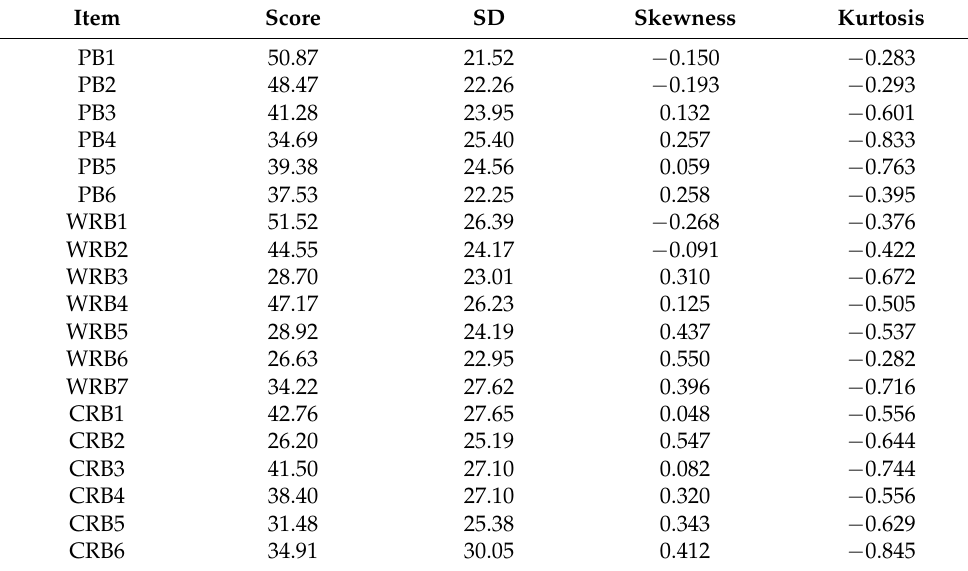
Table 2. Average scores per item of the CBI.